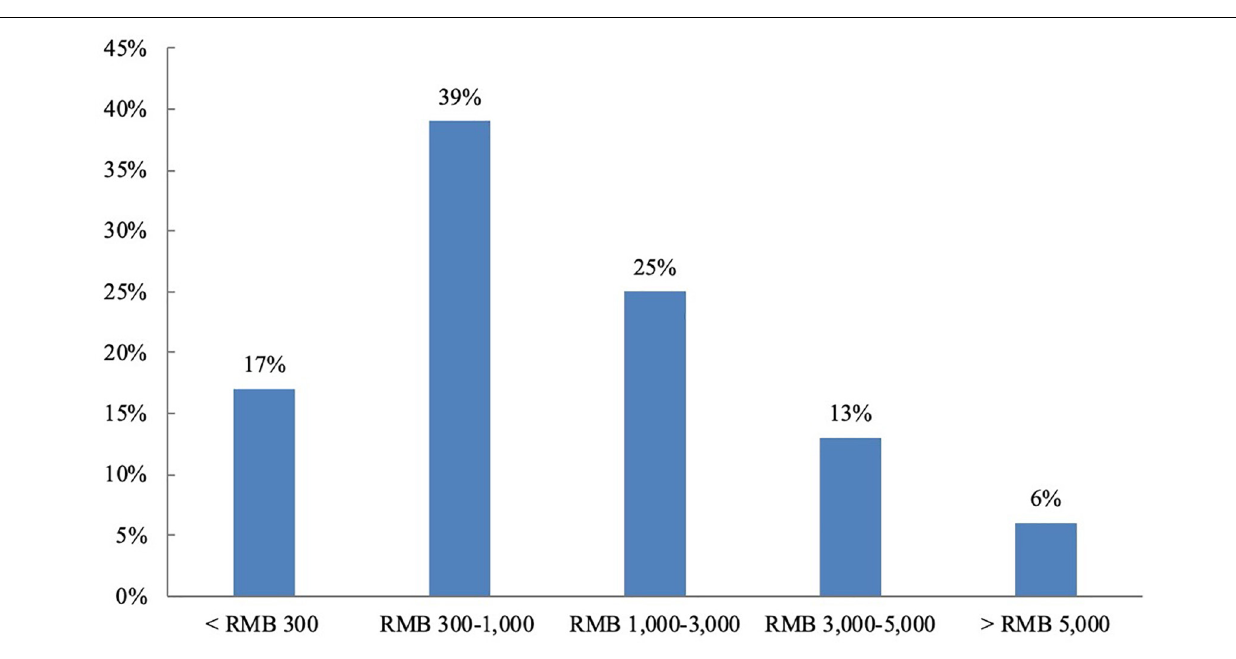
FIGURE 3 | Proportion of sample vendors participating in projects of different